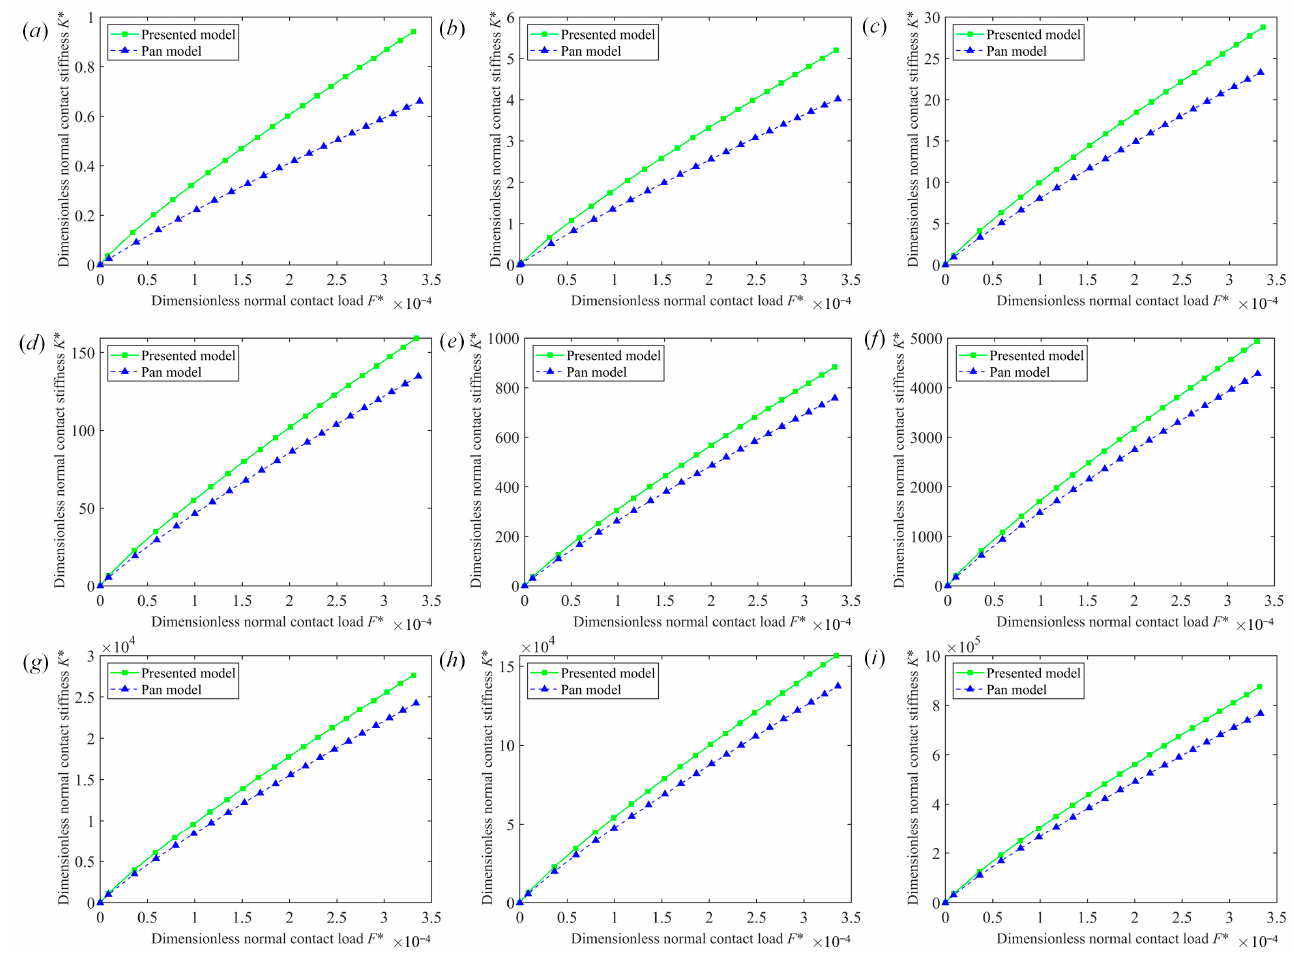
Figure 6. Comparison results between simulation results of the presented model and the Pan model under different G* : ( a ) G* = 10 − 2 ; ( b ) G* = 10 − 3 ; ( c ) G* = 10 − 4 ; ( d ) G* = 10 − 5 ; ( e ) G* = 10 − 6 ; ( f ) G* = 10 − 7 ; ( g ) G* = 10 − 8 ; ( h ) G* = 10 − 9 ; ( i ) G* = 10 − 10